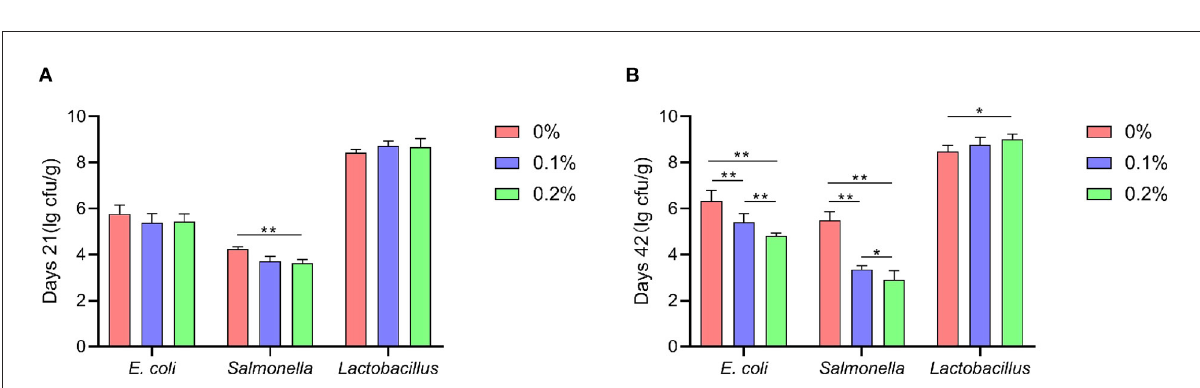
FIGURE3 Effect of PC addition to diets on the fecal microbiota in AA + broilers. (A) Days 21. (B) Days 42. “*” means indicates a significant difference ( P < 0.05). “**” means indicates a extremely significant difference ( P < 0.01). No “*” indicates that the difference is not significant ( P > 0.05).